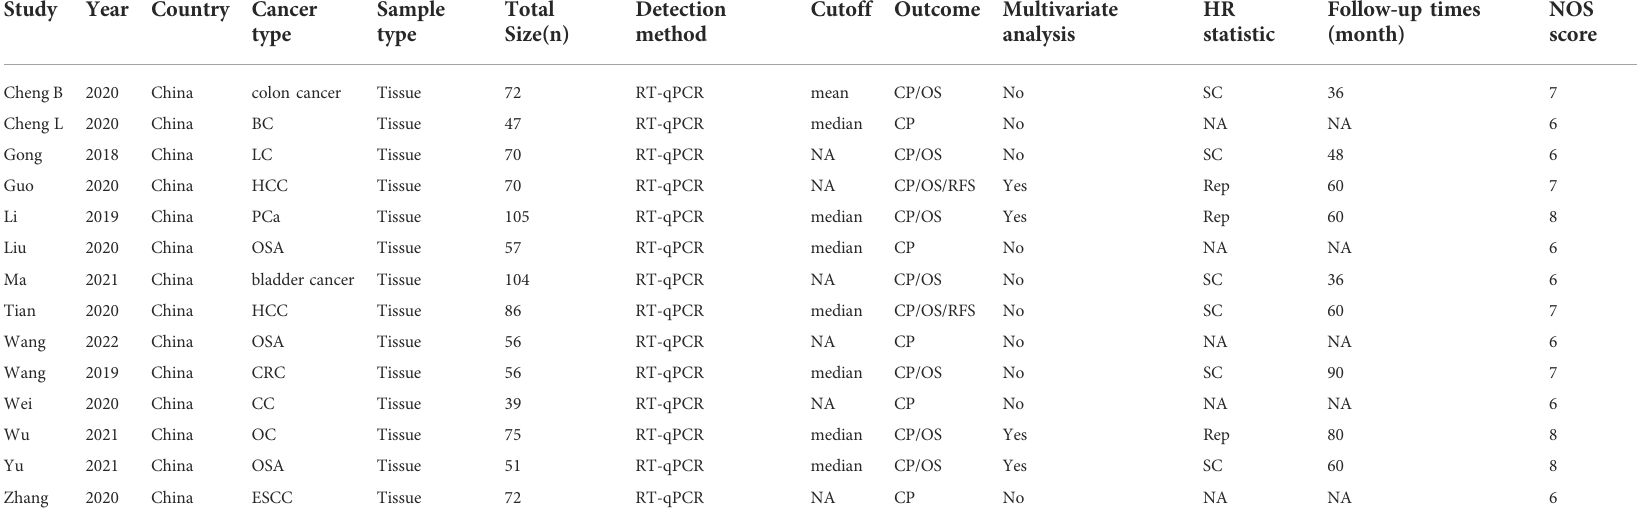
TABLE 1 Characteristics of studies in this meta-analysis.